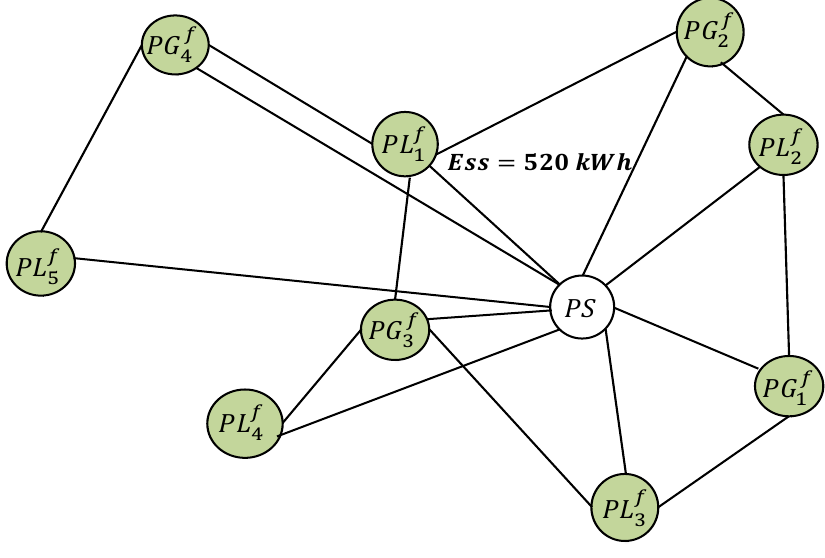
Figure 23. Imaginary system configuration for checking the lower bound for total Ess